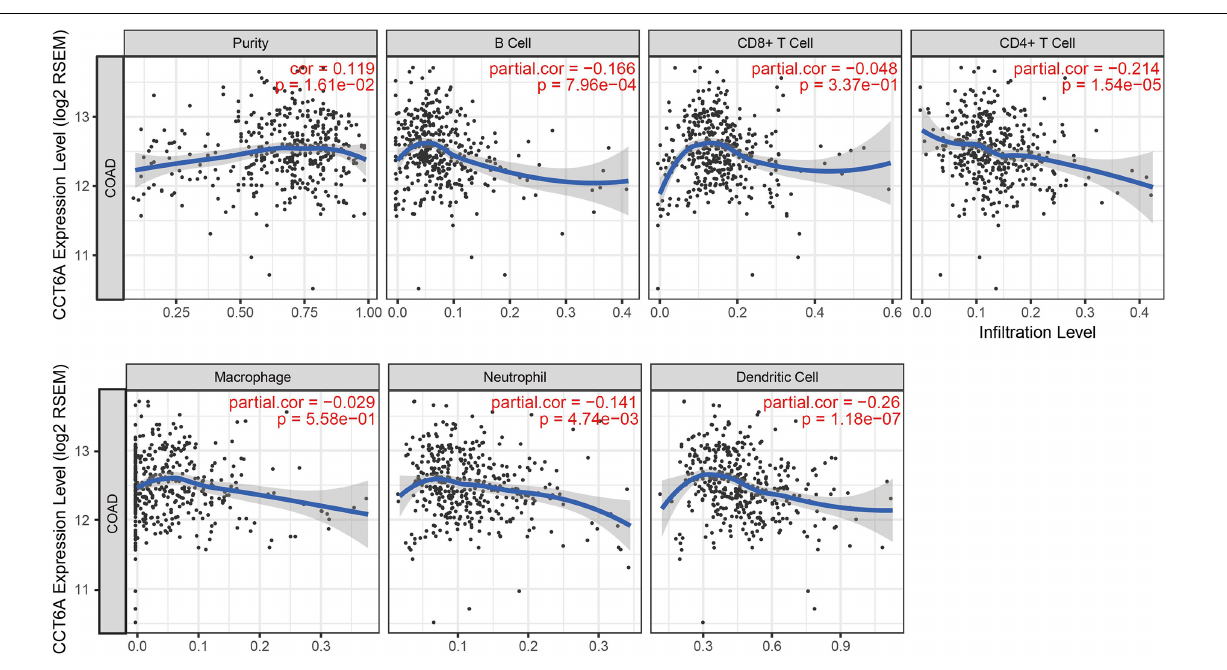
This study also sought to clarify the association between tumor immune cell infiltrates and CCT6A expression in COAD. Lower CCT6A expression was associated with higher infiltrating